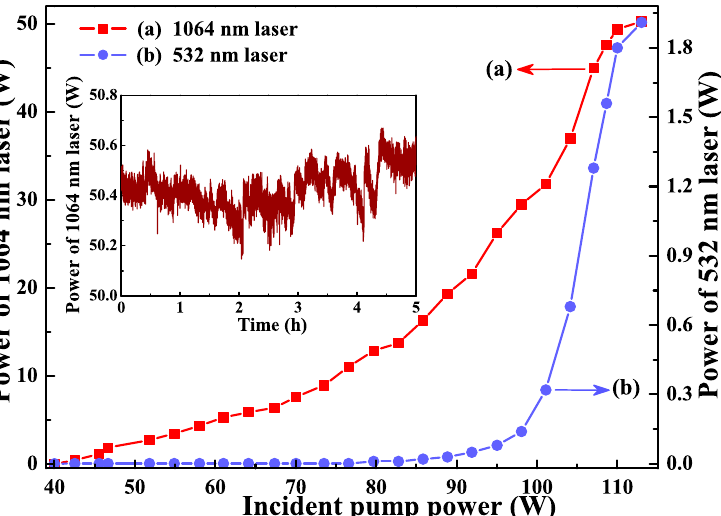
Figure 5. Output power of 1064 nm laser ( a ) and 532 nm laser ( b ) versus incident pump power. Inset showed power stability during 5 h [24]. Reprinted with permission from [24] c (cid:13) The Optical